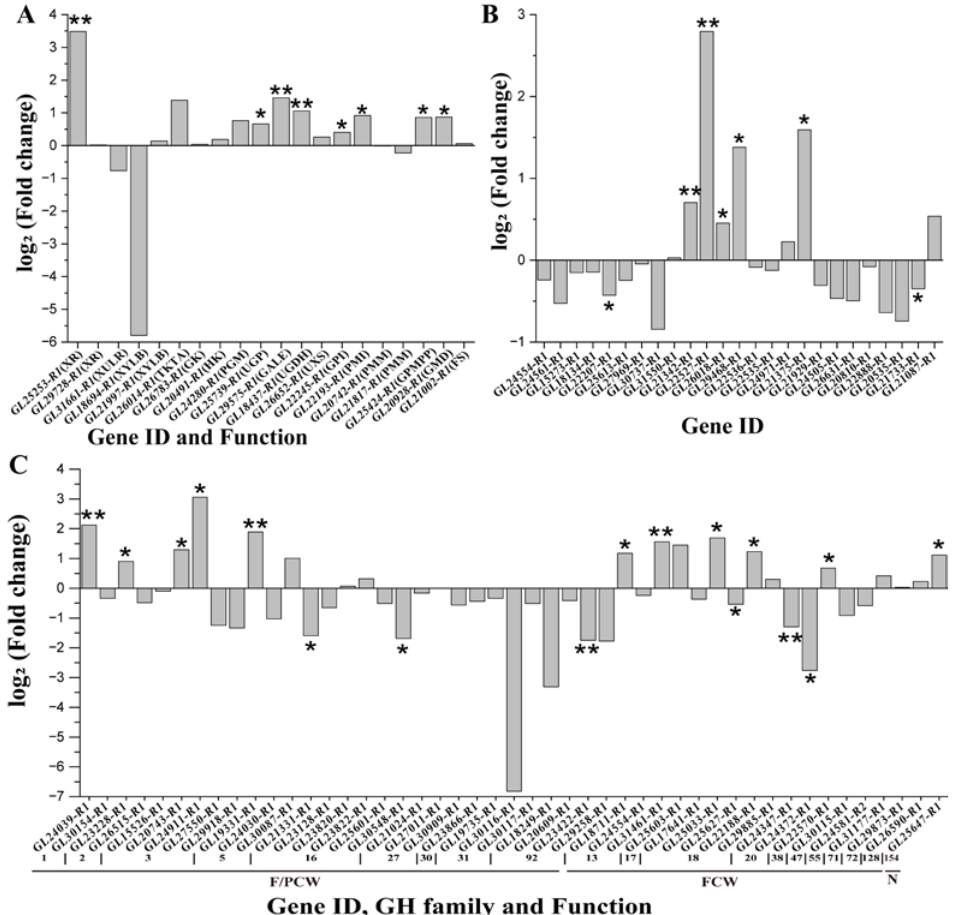
Figure 5. All proteins identified in the polysaccharide biosynthetic pathway of Ganoderma lucidum and the correlation analysis of the mRNA and proteins based on the log 2 (fold change). ( A ) The genes and proteins in nucleoside sugar biosynthetic pathway. ( B ) Glycosyltransferases family of genes and proteins. ( C ) Glycoside hydrolase family of genes and proteins. *: Differentially expressed proteins (**: p < 0.005; *: 0.005 < p < 0.05). Table 2. Properties of the key glycosyl hydrolase proteins for polysaccharide biosynthesis. GH Family Gene